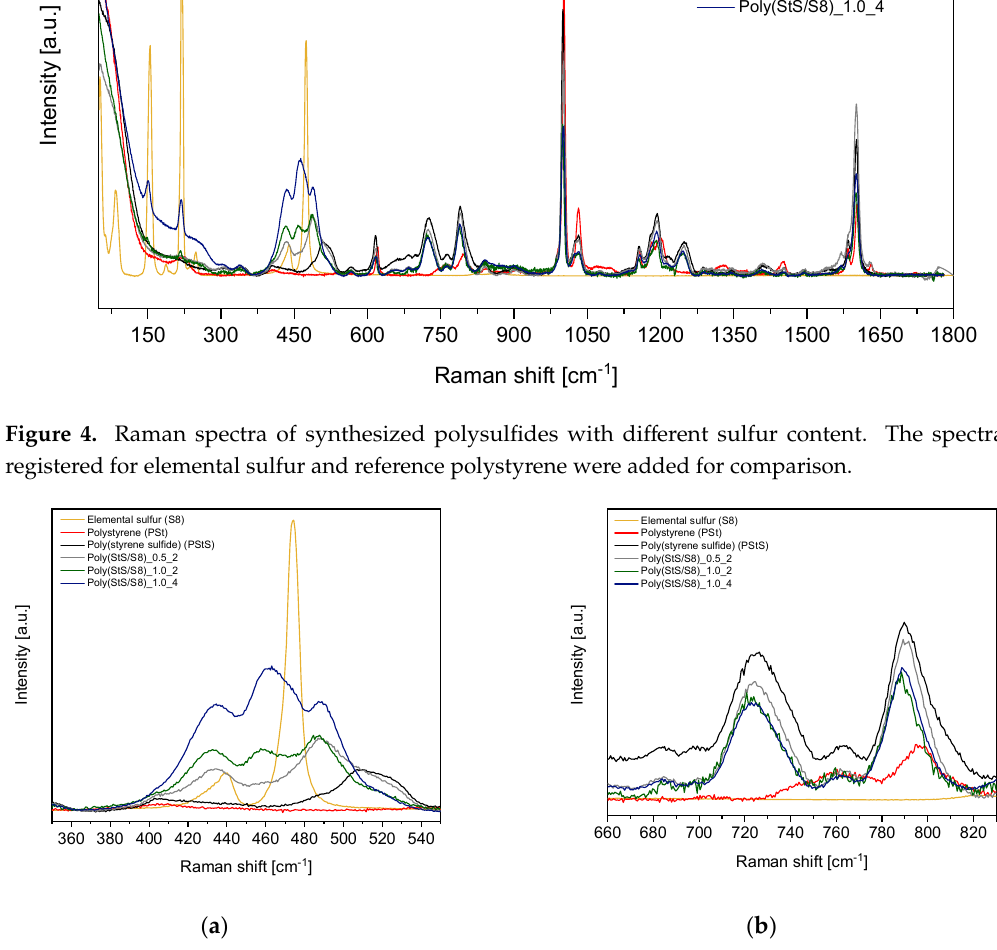
Figure 5. Raman spectra of synthesized polysulfides: ( a ) in the range characteristic for the polysulfide (-S x -) bonds, and ( b ) in the range characteristic for the C–S bonds.